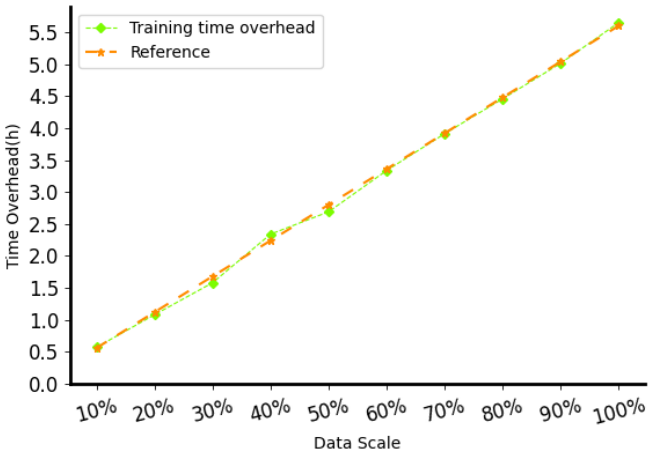
Figure 12. Training time overheads compared with a straight reference